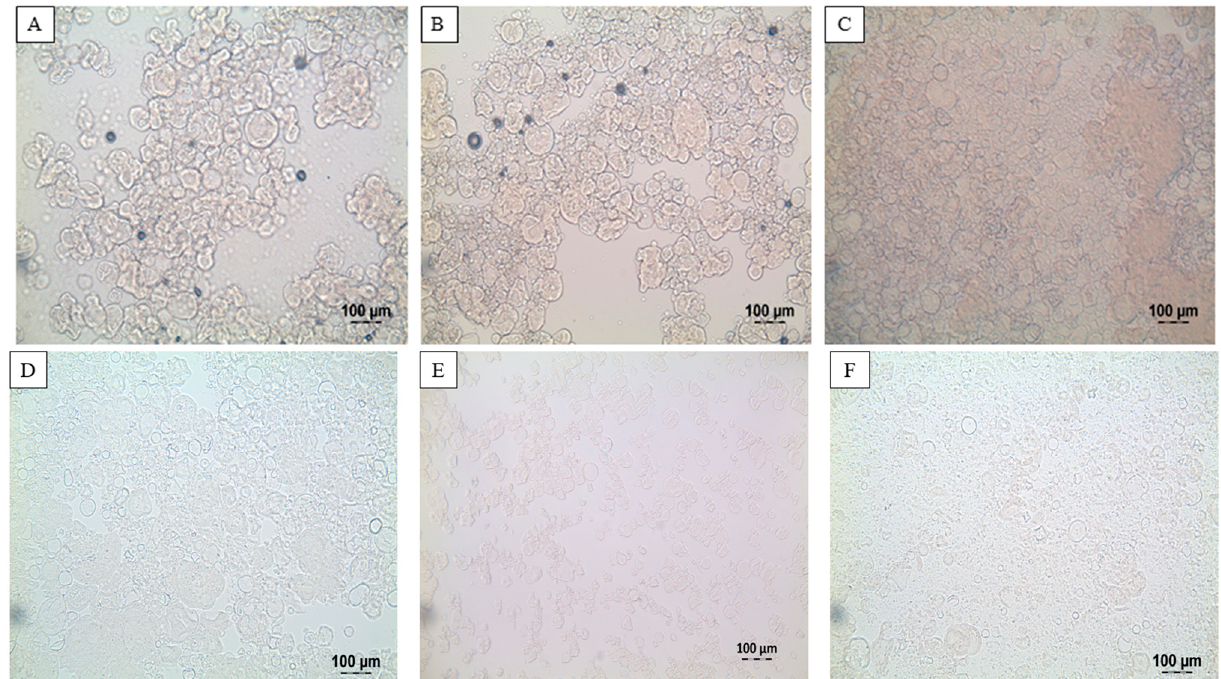
Figure 2. Light microscopy images of soy protein isolate dispersions before heat treatment at pH 2.0 ( A ), pH 6.9 ( B ), and pH 9.0 ( C ) and after heat treatment at 90 °C for 20 min at pH 2.0 ( D ), pH 6.9 ( E ), and pH 9.0 ( F ).